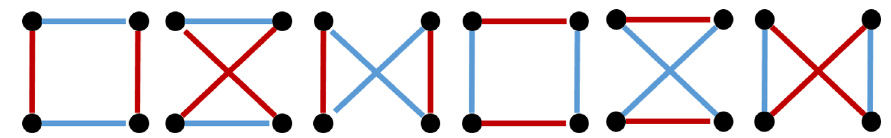
Figure 13. Red lines indicate Z type gauge operators and blue lines are X type gauge